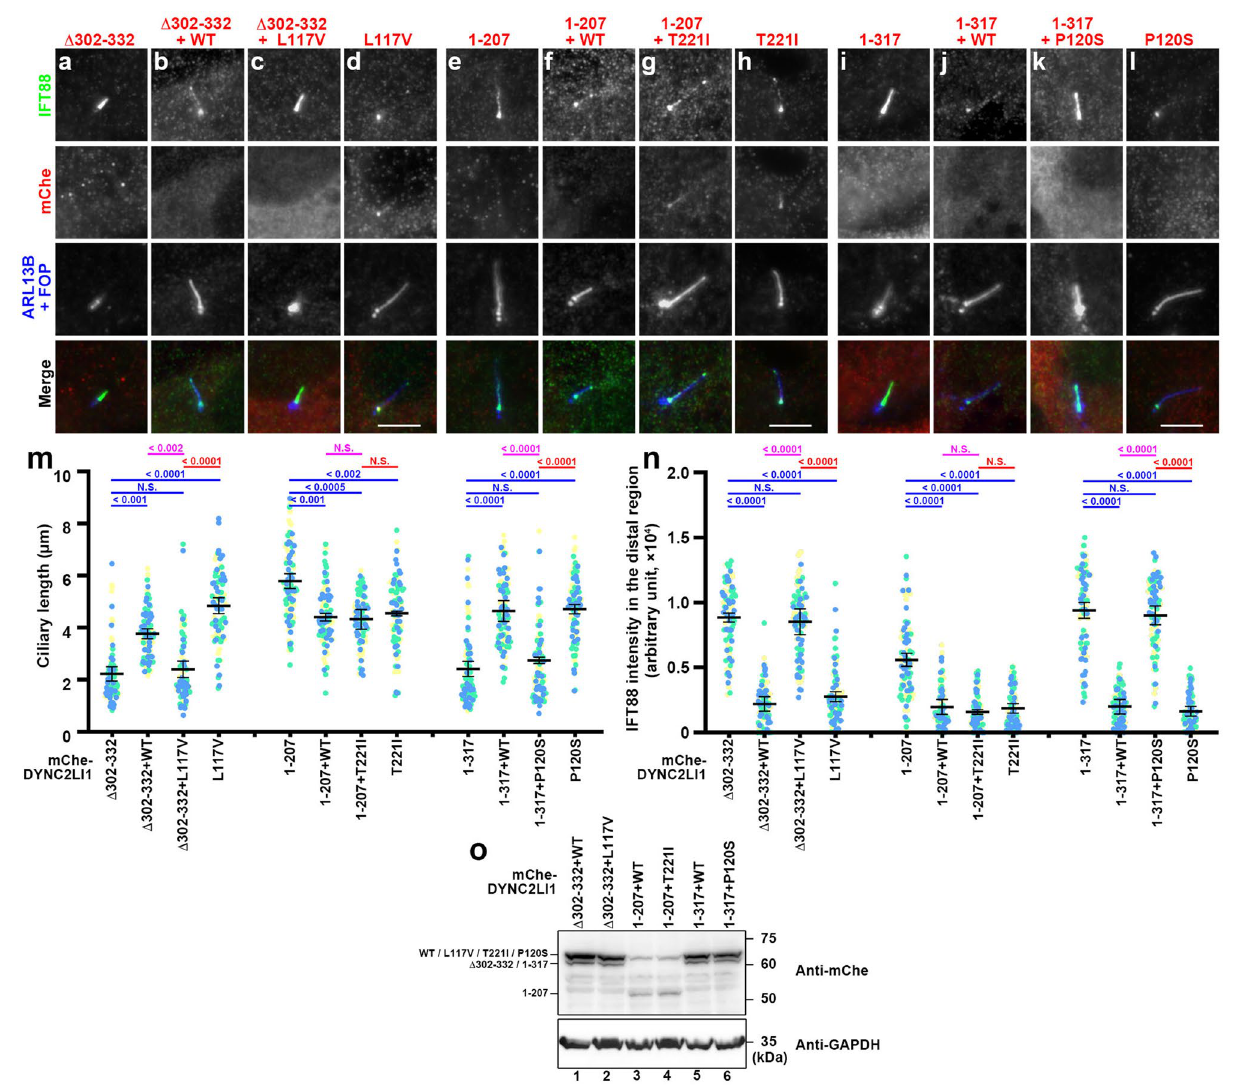
Figure 4. Specific combinations of DYNC2LI1 variants are unable to rescue defects in ciliogenesis and IFT88 localization in DYNC2LI1 -KO cells. ( a – l ) DYNC2LI1 -KO cells expressing the indicated mChe-fused DYNC2LI1 construct or the indicated combinations of mChe-fused DYNC2LI1 constructs were serum-starved for 24 h and immunostained with antibodies against IFT88 and ARL13B + FOP. Scale bars, 5 µm. ( m , n ) Ciliary lengths of individual cells and staining intensities for IFT88 in the distal region of cilia in the experiments shown in ( a – l ) were measured and expressed as scatter plots, and analyzed as described in the legend to Fig. 2k,l, respectively. ( o ) Immunoblotting analysis of equivalent amounts of cell lysates coexpressing the indicated combinations of mChe-fused DYNC2LI1 constructs, with an anti-mChe